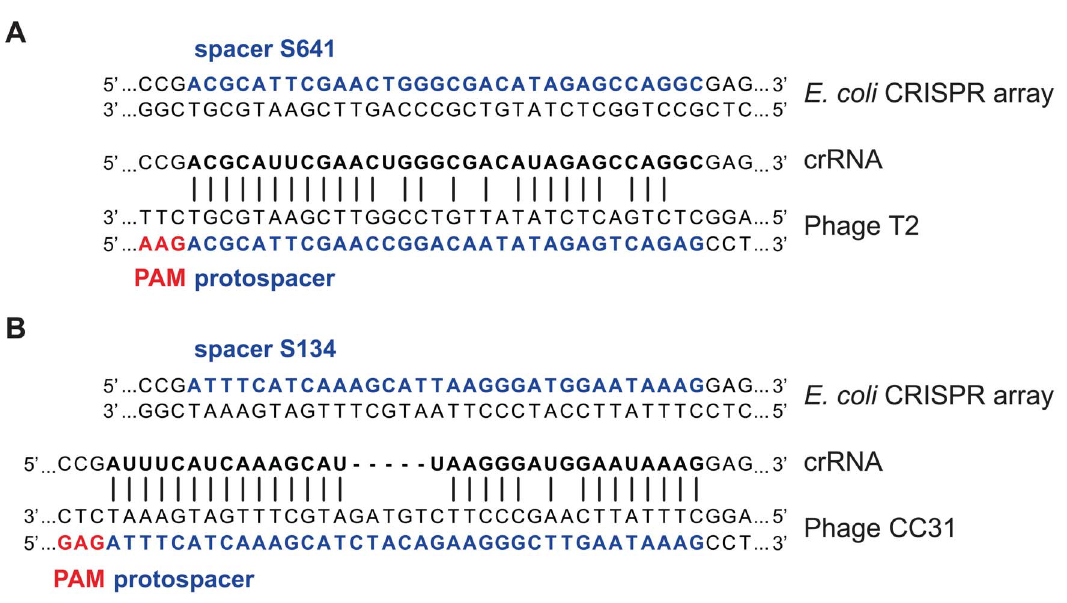
Figure 1. Native E.coli spacers target phage with modified DNA. In a BLASTn search, 1749 unique spacers from sequenced E. coli CRISPR arrays were queried against T4-like phage genomes. (A) Spacer S641 matches 25 of 32 nucleotides in phage T2. The putative protospacer has a permissible E. coli CRISPR PAM AAG and the matching nucleotides are concentrated at the 5 9 end as a seed sequence. The spacer originated from the CRISPR1 locus of E. coli strain 579, a human-associated isolate from France. (B) Spacer S134 matches 29 of 32 nucleotides in phage CC31. While the protospacer in phage CC31 has five nucleotides inserted in the center of the sequence, there are 15 exactly matched nucleotides at the 5 9 end in addition to 14 matched nucleotides after the insertion. The PAM GAG and strongly matched seed region suggest it is a plausible E. coli CRISPR target. This spacer was found in several strains, including E. coli C str. ATCC 8739, ECOR strains 17 through 21, one farm pig and two human fecal samples in France, duck and cattle fecal samples in Australia [33], and enterotoxigenic E. coli (ETEC) strain UMNK88. The spacer and matching protospacer are in blue, the transcribed CRISPR RNA (crRNA) in bold black, and PAM sequence in red.